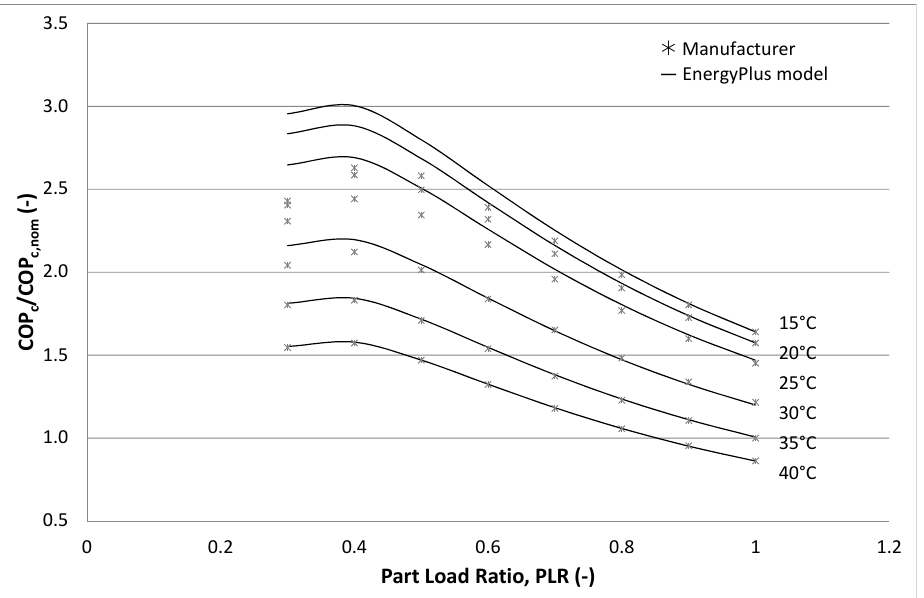
Figure 1. Variation of the cooling coefficient of performance (COP) ratio as a function of part load ratio and outdoor dry-bulb temperature (manufacturer and EnergyPlus variable refrigerant flow (VRF) model).